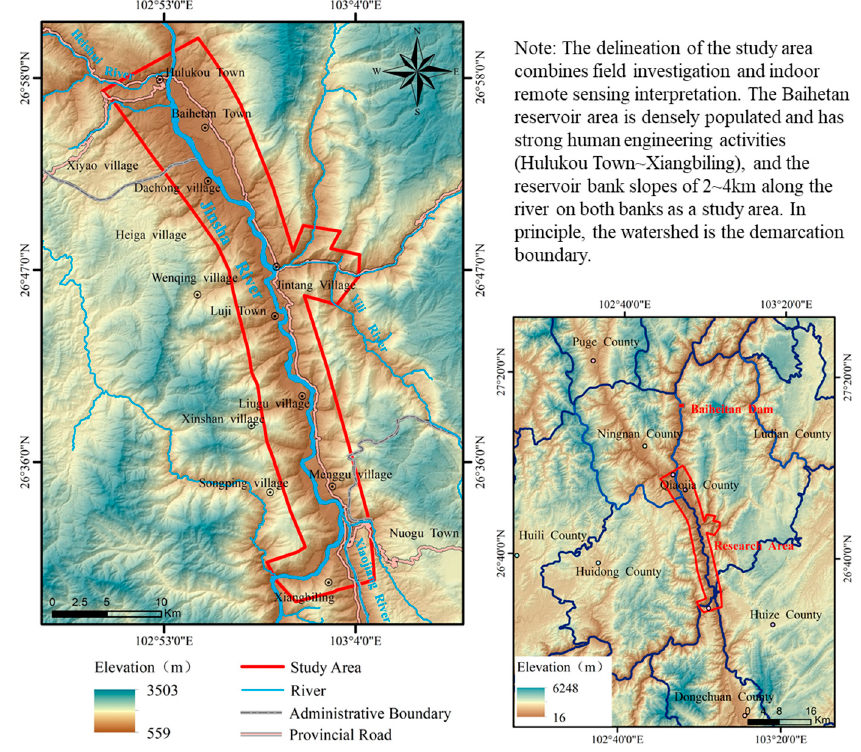
Figure 1. Geographical position map of the study area.